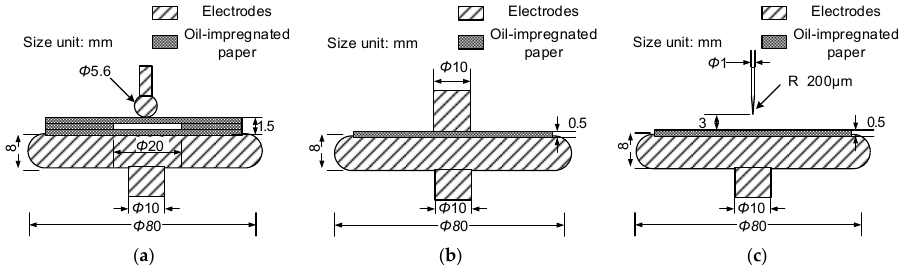
Figure 6. Three types of artificial defect models in insulation oil: ( a ) the air ‐ void discharge model; ( b ) the surface discharge model; and ( c ) the corona discharge model.